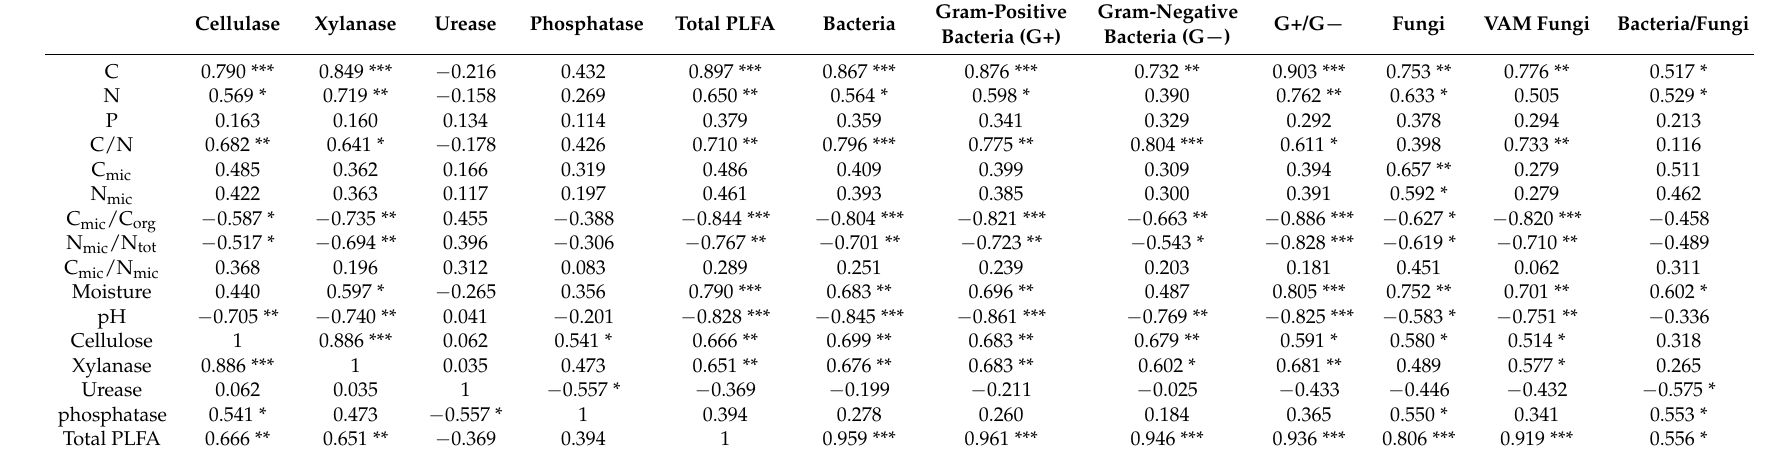
Table 4. Pearson’s correlation coefficients for soil properties, soil enzyme and microbial